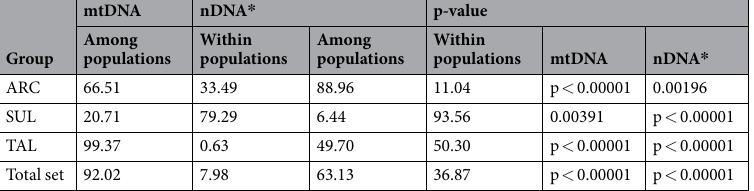
Table 1. Results of a two-level AMOVA of genetic differences for both mtDNA and nDNA sequences of the three main clades of the C . typus species-complex. Notes: Entries represent the percentage of the total variance that is explained by variation within and among the populations defined by Geneland. * Due to the great amount of missing data, the AMOVA for all the samples with nuclear markers was performed with only Ct33, which has the most complete dataset.